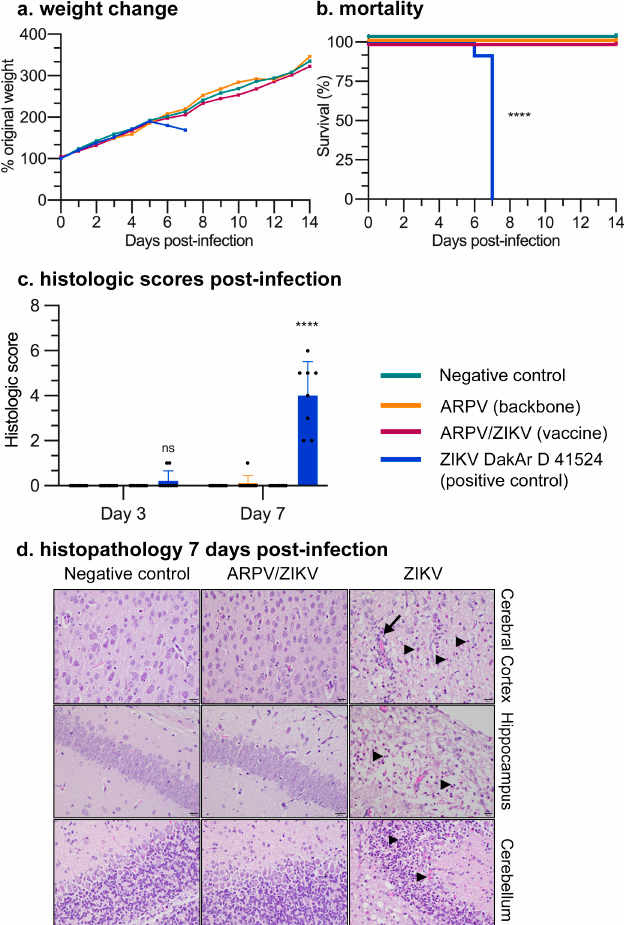
Figure 3. ARPV/ZIKV shows exceptional safety in a suckling mouse model. ARPV/ZIKV demonstrated no pathological effects after i.c. inoculation of between four- to five-day-old CD-1 suckling mice. Mice were inoculated with one of the indicated agents, or with saline as a negative control. ( a ) Weight change monitored over 24 days post-infection (dpi). Litters of mice were weighed as a group each day. Data points represent mean values. ( b ) Kaplan–Meier survival plot of suckling mice post-infection, with significance analyzed by log-rank (Mantel–Cox) test. No mice infected with ZIKV DakAr D 41524 survived past 7 dpi. ( c , d ) Mice (n = 3–7) from each group were sacrificed at 3, 7 and 14 dpi and brain samples taken for H&E staining. ( c ) Sections were graded according to amount of inflammation (0–3), necrosis (0–3) and evidence of demyelination (0–3). Higher composite scores reflect more severe histologic lesions. Columns indicate mean values and error bars indicate SD of the mean. Circles represent individual mouse data points. Significance was determined by two-way ANOVA. ( d ) Representative images (40 × magnification) taken 7 dpi. The cerebral cortex is highlighted in the top panels, hippocampus in the middle panels and cerebellum in the bottom panels. Indicated are regions of neuronal necrosis (arrowheads) and inflammation (arrow). Unless otherwise marked, asterisks indicate significance compared to saline-inoculated negative controls: not significant (ns), p ≤ 0.0001